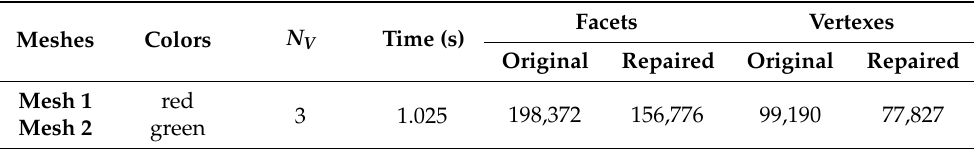
Figure 7. The multi-labeled mesh with input three sub-meshes.